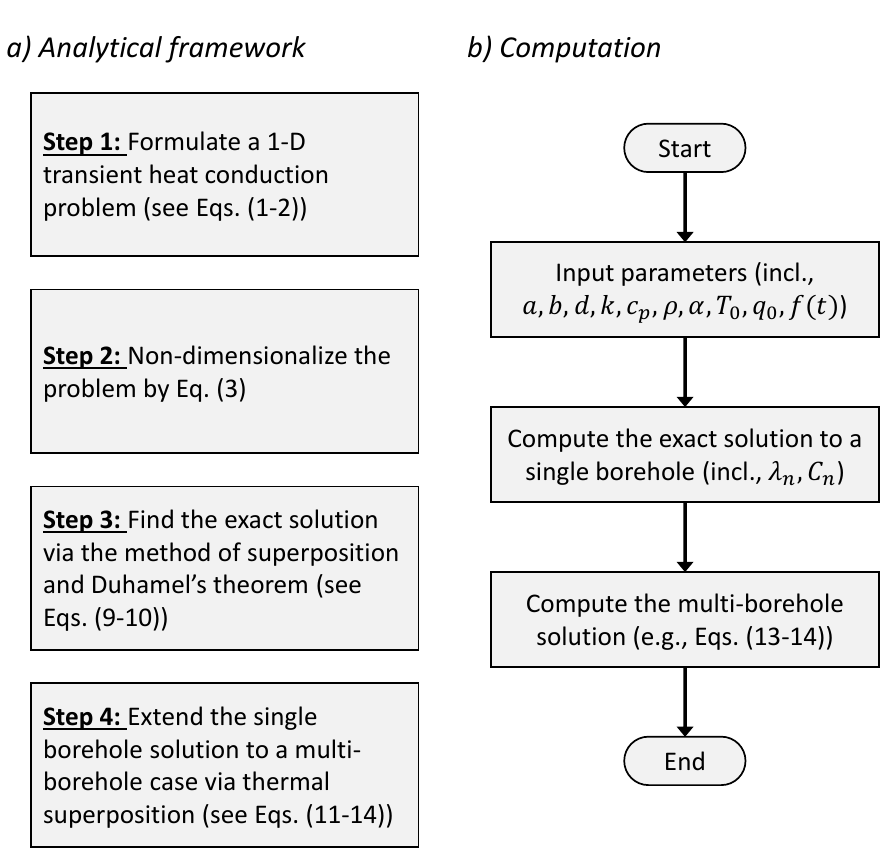
Figure 3. Flow chart of: ( a ) the presented analytical framework and ( b ) its